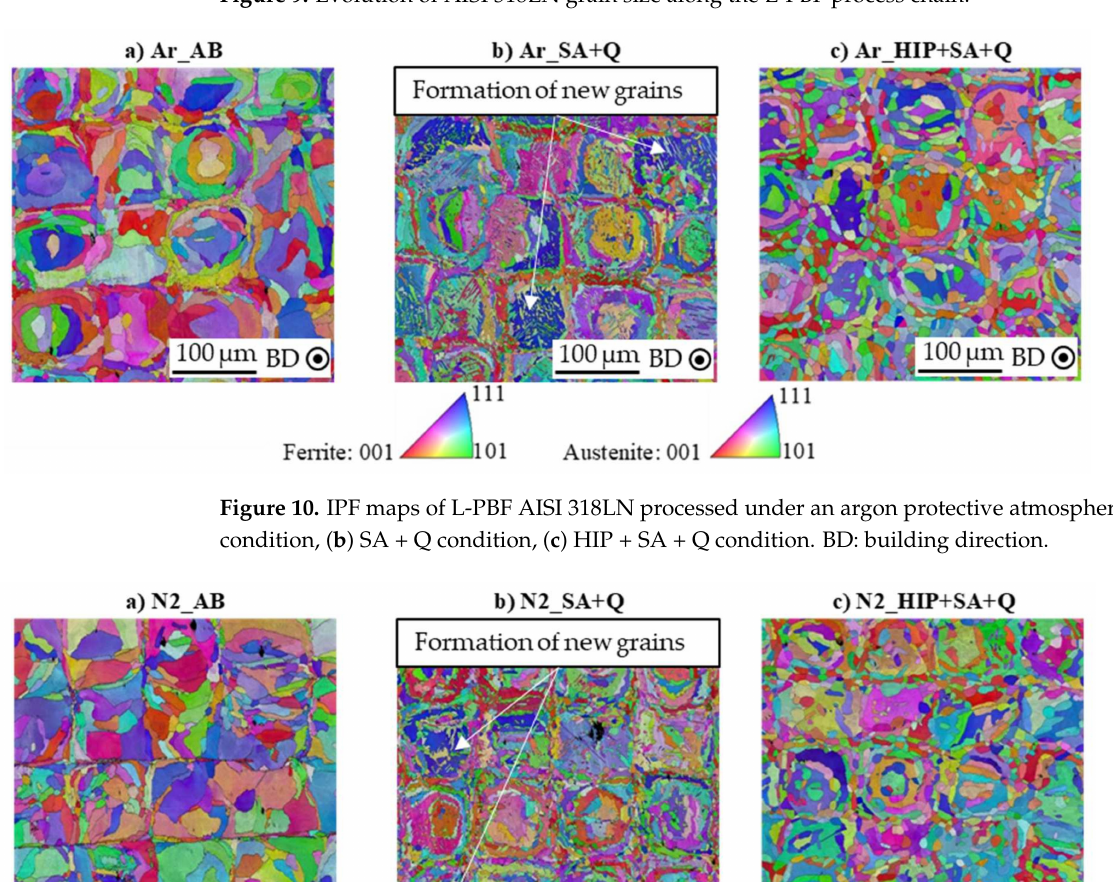
Figure 9. Evolution of AISI 318LN grain size along the L-PBF process chain.